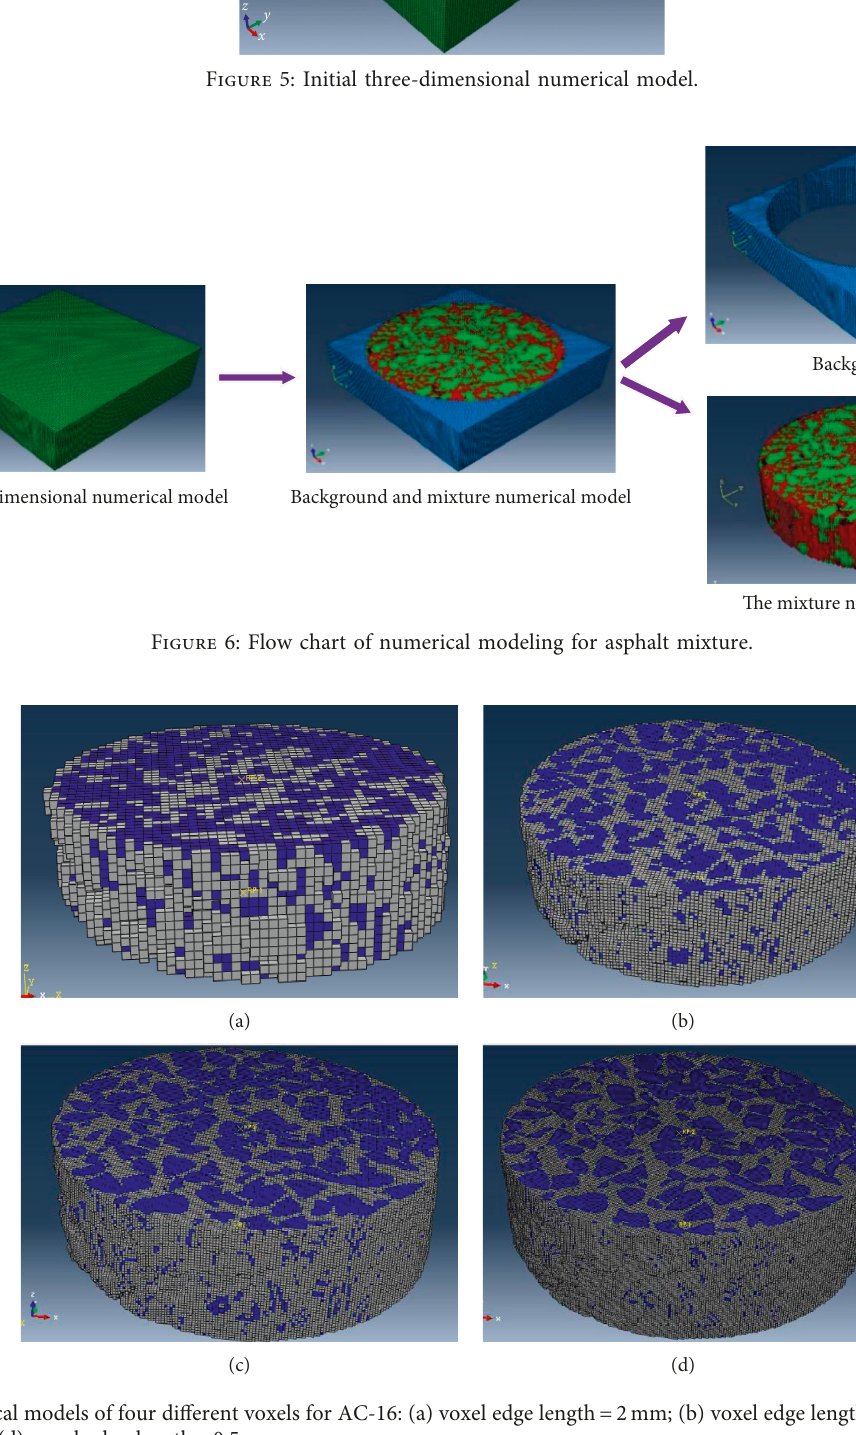
Figure 7: Numerical models of four different voxels for AC-16: (a) voxel edge length � 2mm; (b) voxel edge length � 1mm; (c) voxel edge length � 0.67mm; (d) voxel edge length � 0.5 mm.